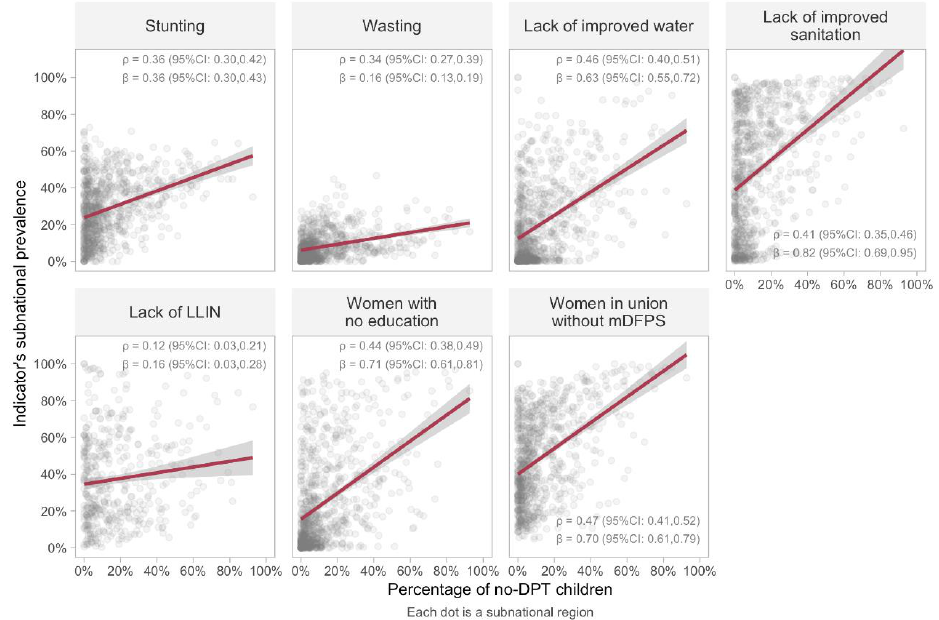
Figure 4. Associations between no-DPT prevalence and prevalence of deprivation indicators in 827 subnational areas (445 for bed nets). Linear regression lines are shown in red, and 95%CI in grey. ρ: Spearman correlation coefficient. Legend: DPT: diphtheria, pertussis, tetanus. LLIN: long-lasting insecticidal nets. mDFPS: demand for family planning satisfied with modern methods. CI: confidence interval.